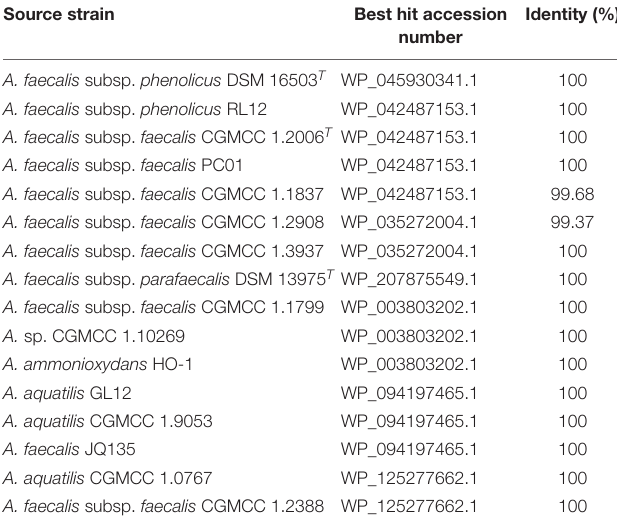
TABLE 4 | BlastP results of DnfAs against NR